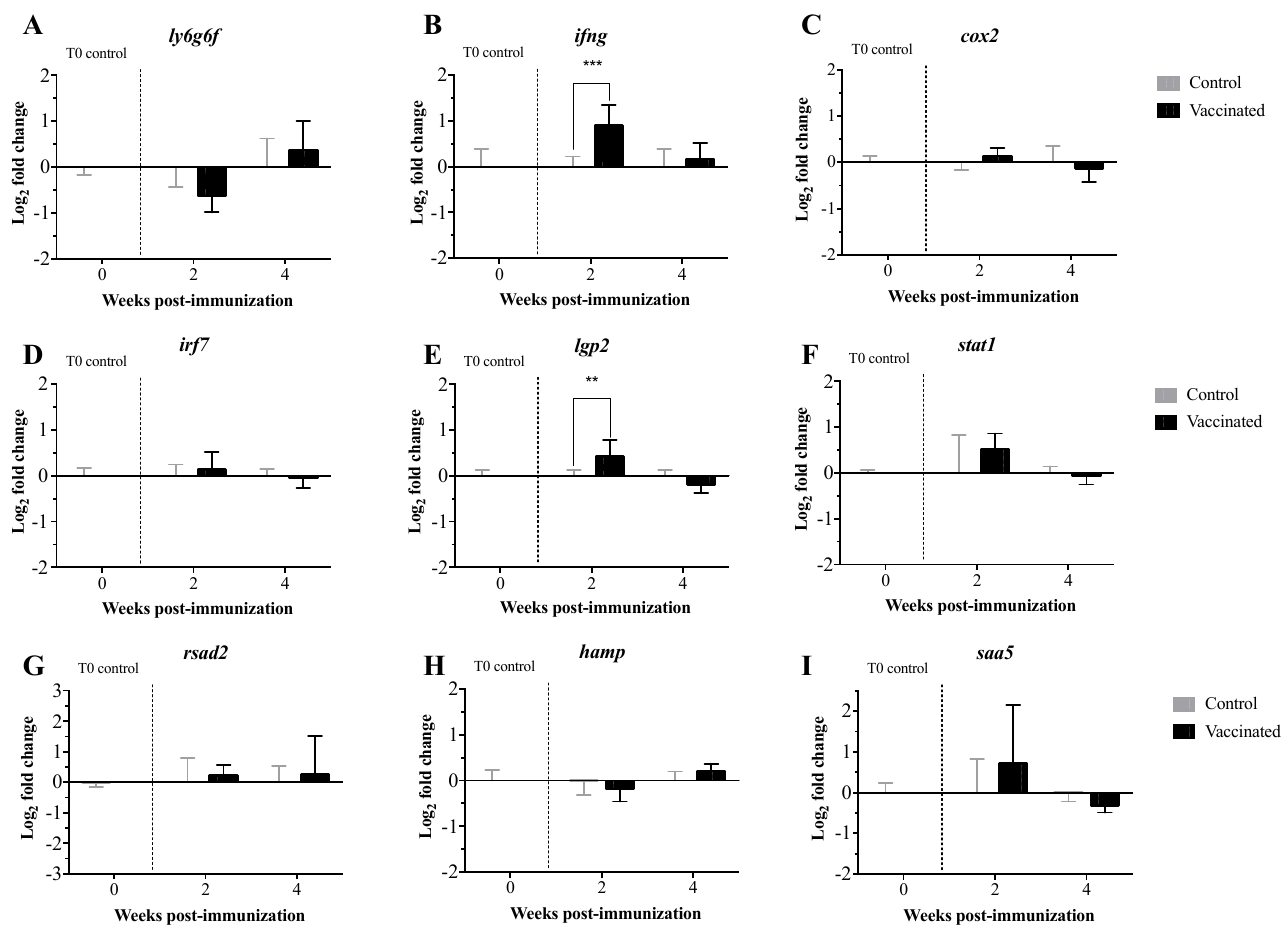
Figure 6. Transcript expression levels of other immune-related genes in lumpfish larvae orally immunized with the V. anguillarum bacterin bio-encapsulated in A. salina nauplii ( A – I ). Transcript expression levels were assessed pre-immunization (T0 control, n = 3 individual pools of 10 larvae each), 2 weeks post-immunization ( n = 3 pools of 10 larvae each), and 4 weeks post-immunization ( n = 3 pools of 5 larvae each). Time point controls post-mock immunization were collected in a similar fashion to those collected at weeks 2 and 4. Relative expression was calculated using the 2 ( − ∆∆ Ct) method and normalized using log 2 ; etif3d and rpl32 were used as endogenous controls. A two-way ANOVA test followed by the Sidak multiple comparisons post hoc test were used to assess significant differences between the treatments (control and vaccinated) at each individual time point. Asterisks (*) represent significant differences (** p < 0.01, *** p < 0.001).